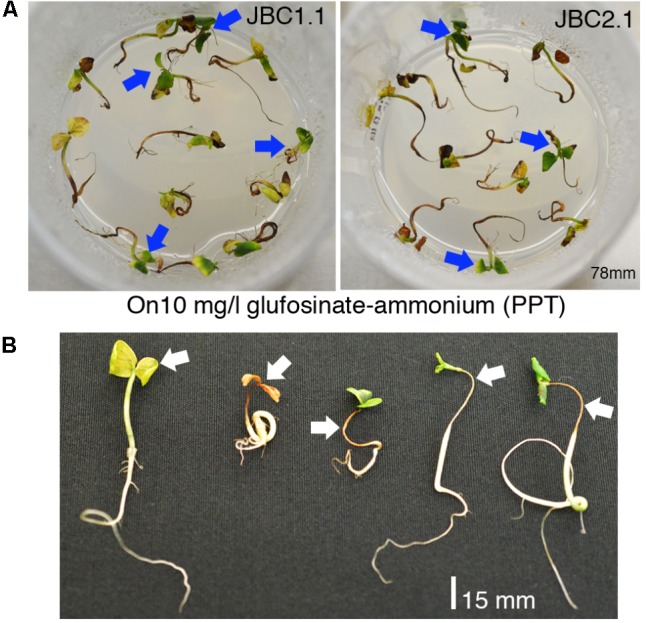
Selection of T1 seedlings in 10 mg/l glufosinate ammonium. (A) Positive seedlings successfully grown in high dose of PPT (Blue arrows). (B) The negative plants (White arrows), showing browning of stem and root, rapid degradation of cotyledon chlorophyll, no lateral root formation, and necrosis.